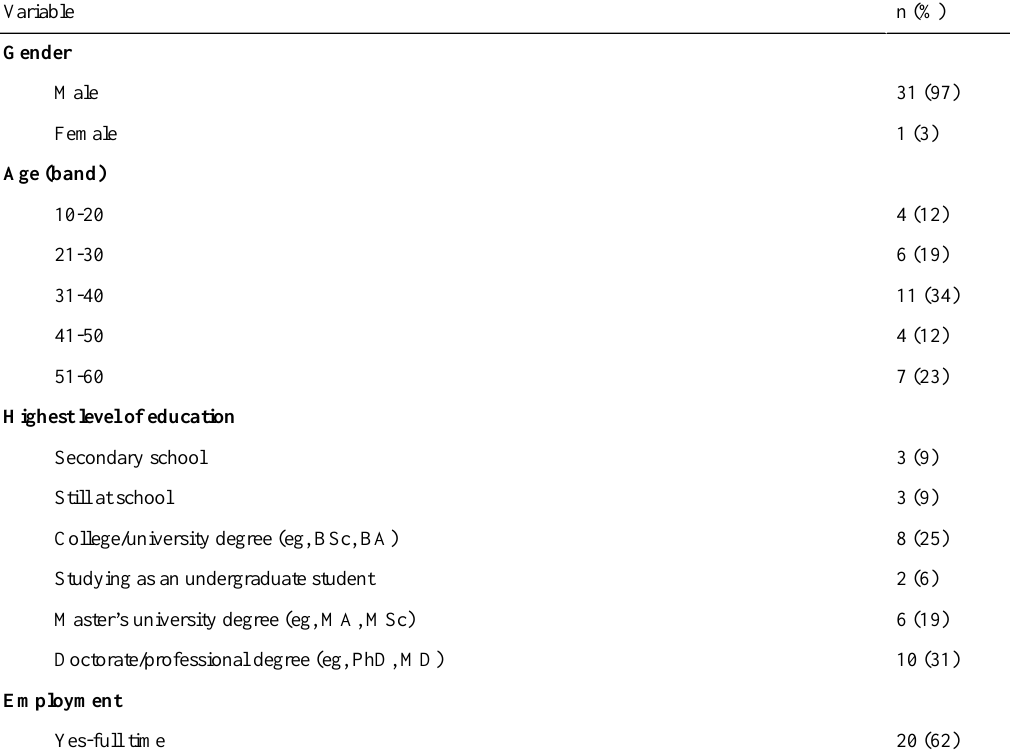
Table 2. Participant characteristics